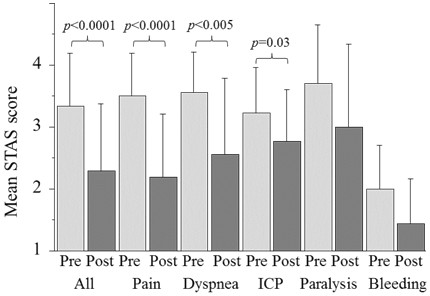
Mean STAS scores pre- and postpalliative radiotherapy. ICP: increased intracranial pressure.